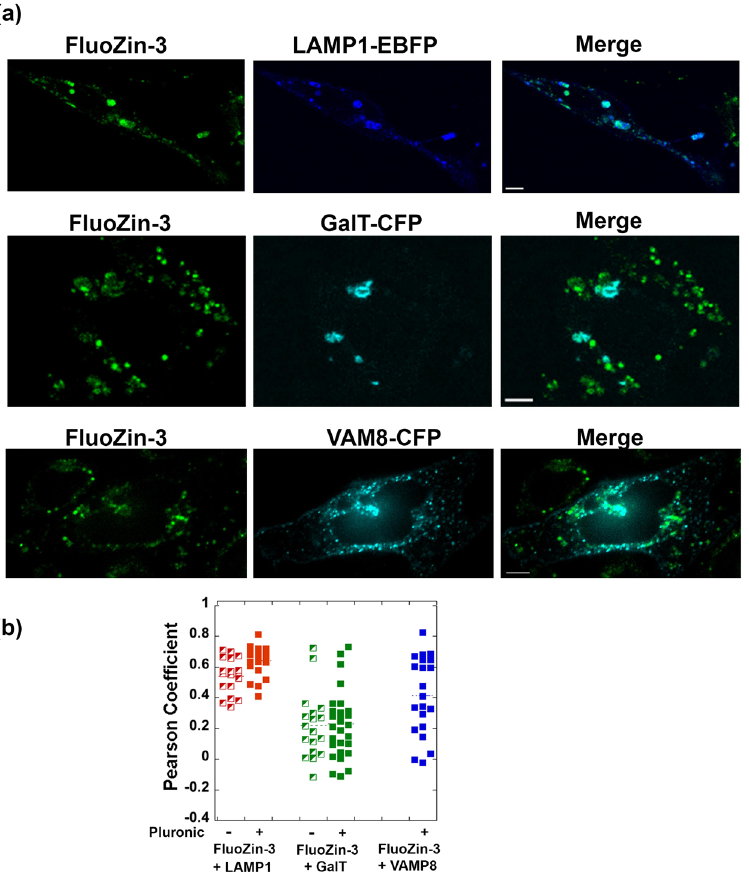
Figure 4. Co-localization analysis of FluoZin-3 and three vesicular markers demonstrates that FluoZin-3 non-specifically localizes to lysosomal, Golgi, and secretory vesicles. ( a ) Representative fluorescence images of Spirozin2-stained cells, vesicular markers- FP, and the merged channel. ( b ) Pearson coefficient plot of co- localization analysis. A minimum of 18 cells were analyzed for each condition. Scale bar, 5 μ